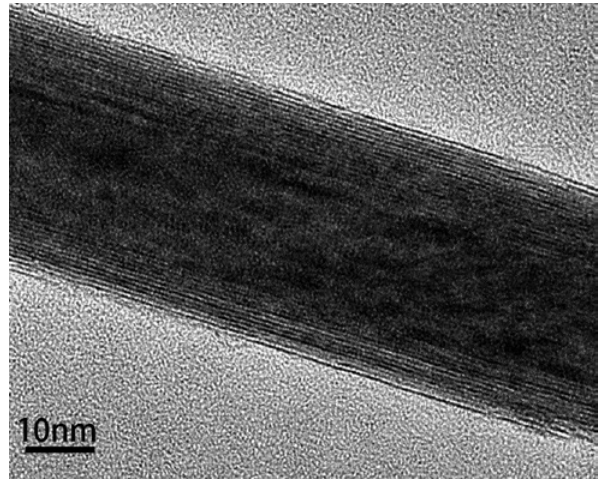
Figure 1: HRTEM image of WS